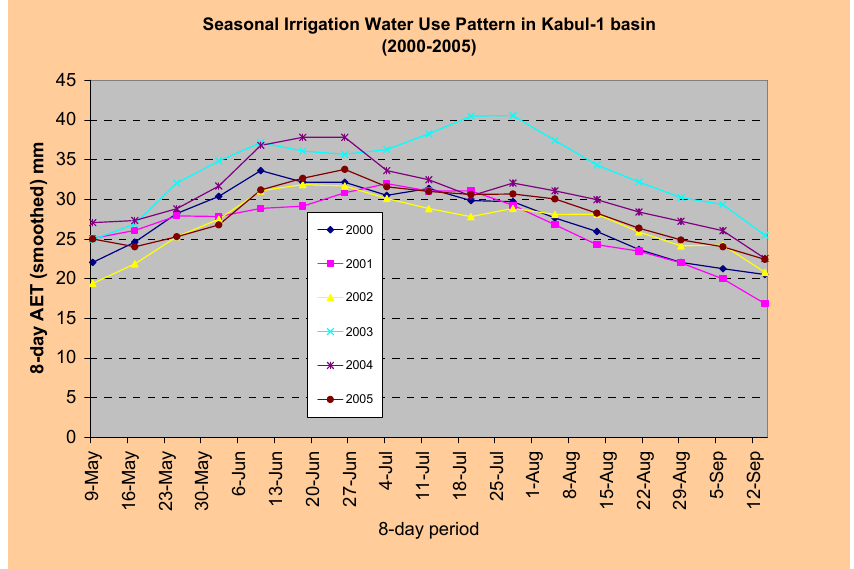
Figure 8. Temporal patterns of seasonal irrigation water use (ETa (AET)) in Kabul 1 for 2000 - 2005. Data is smoothed using a 3-period moving window.